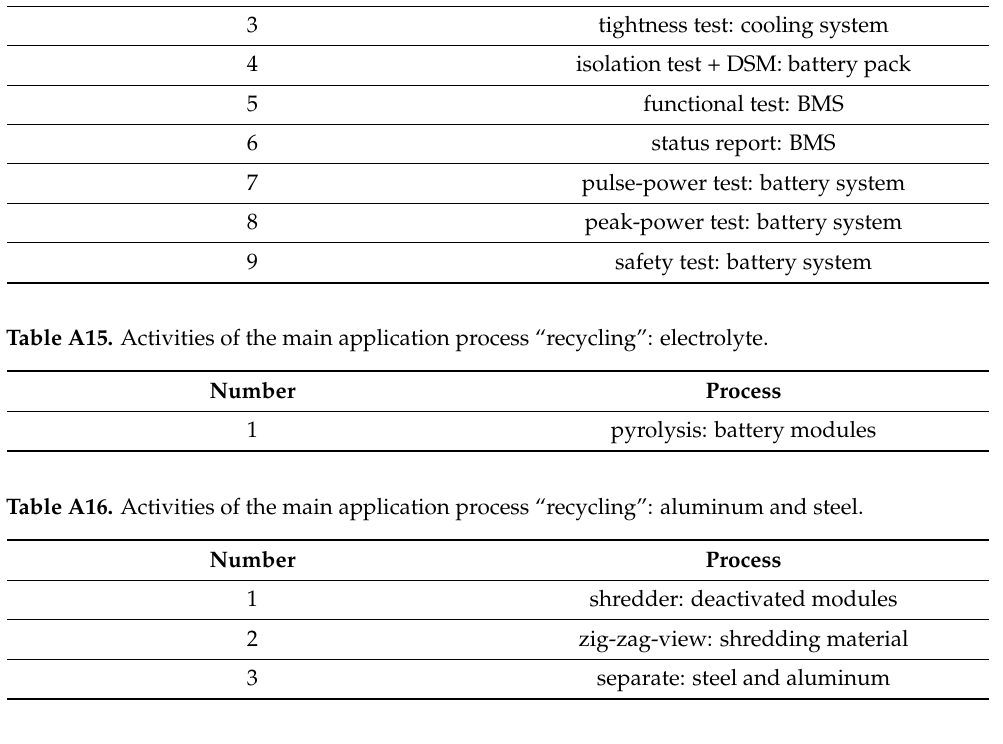
Table A17. Activities of the main application process “recycling”: recovery of aluminum and copper foil.